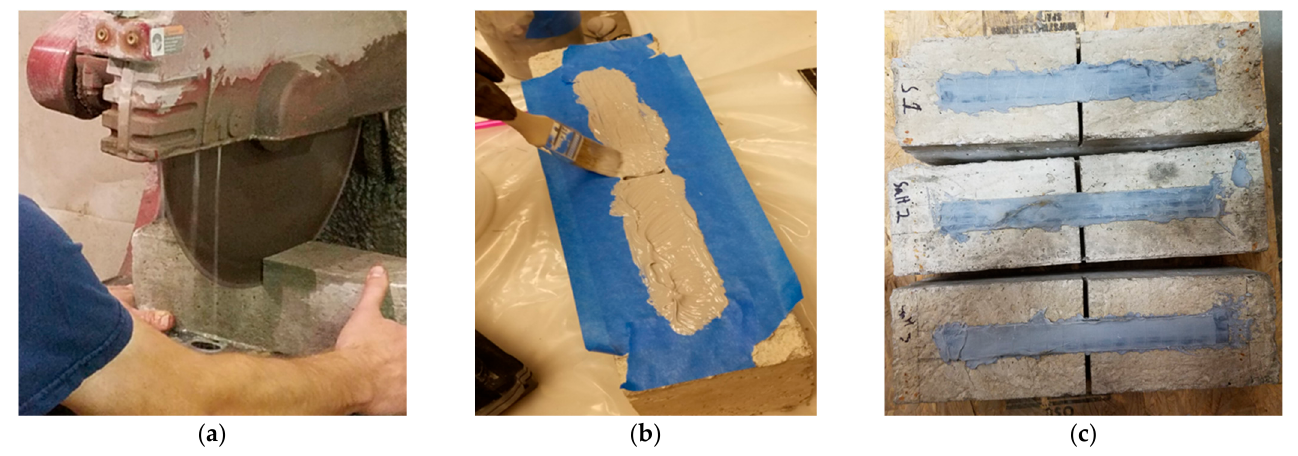
Figure 5. Preparation of the strengthened pre-notched concrete prisms. ( a ) Crack initiation. ( b ) Application of the CFRP sheets to concrete. ( c ) Strengthened specimens.